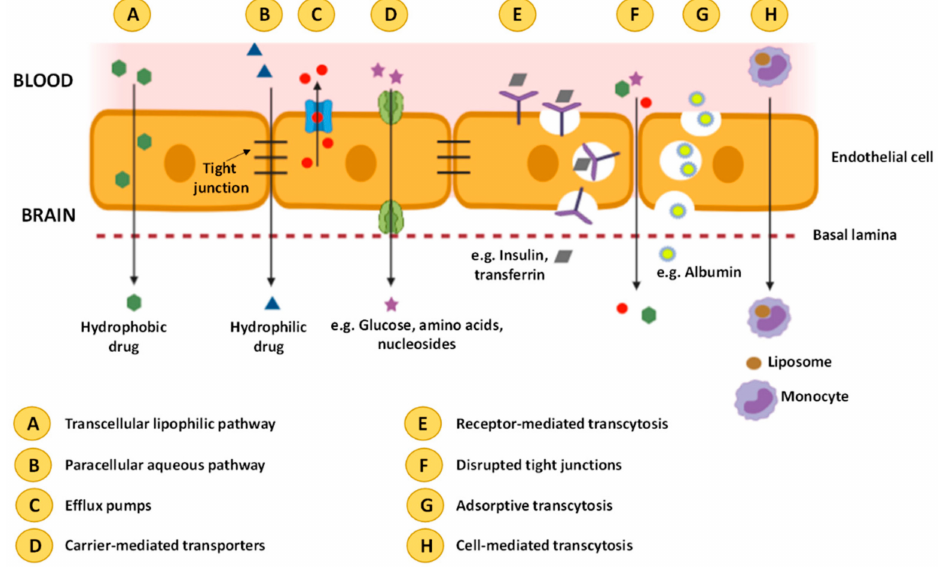
Figure 2. Transport mechanisms across the blood-brain barrier. Adapted from